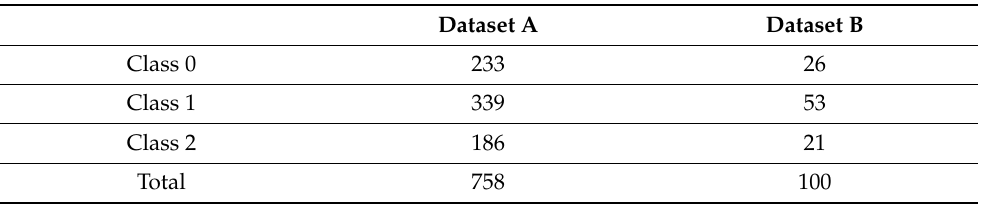
Table 1. Distribution information of datasets. Dataset A was used for training, and dataset B was used for external